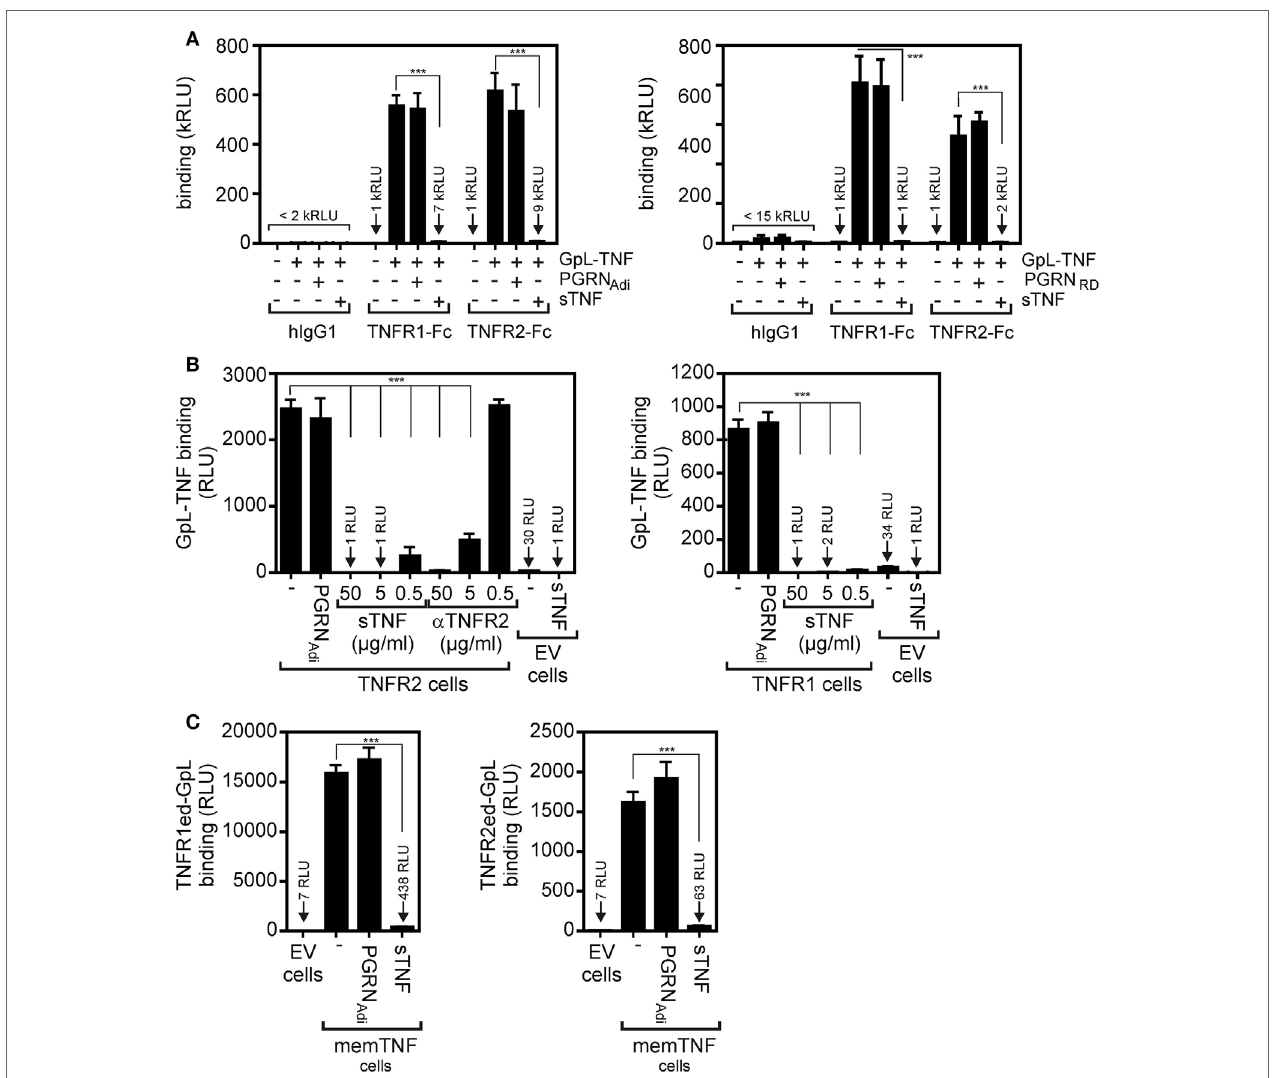
FigUre 1 | Preincubation with purified progranulin (PGRN) samples does not interfere with tumor necrosis factor (TNF)-tumor necrosis factor receptor-1 (TNFR1) and TNF–TNFR2 interaction in cell-free and cellular binding studies. (a) TNFR1-Fc and TNFR2-Fc or an irrelevant human IgG1 (Rituximab) were immobilized to black enzyme-linked immunosorbent assay (ELISA) plates. Where indicated wells were preincubated with 25 µg/ml untagged PGRN from Adipogen (PGRN Adi ) or 25 µg/ml myc-6xHis-tagged PGRN from R&D Systems (PGRN RD ) for 1 h. GpL-TNF was then added to reach a concentration of 10 ng/ml and finally bound GpL-TNF was quantified by measuring its GpL activity. As positive control for successful competitive binding inhibition groups were included, where 10 µg/ml of soluble TNF (sTNF) have been added instead of PGRN. (B) Human embryonal kidney cells 293 (HEK293) cells were transfected with empty vector (EV) or expression plasmids encoding a deletion mutant of TNFR1, where the death domain has been replaced by yellow fluorescence protein (YFP) (TNFR1) or deletion mutant of TNFR2, where the TRAF2 binding site has been replaced again by YFP (TNFR2). Next day, aliquots of cells (1 × 10 6 ) were preincubated with 500, 5,000, or 50,000 ng/ml of sTNF or 50,000 ng/ml PGRN Adi for 2 h at 37°C or remained untreated. Binding studies were performed in technical triplicates with 20 ng/ml GpL-TNF. In the experiment with TNFR2-transfected cells, a group was pretreated with 20 µg/ml of a blocking TNFR2-specific antibody ( α TNFR2). Please note, GpL-TNF binding of EV-transfected cells in the presence and absence of an excess of sTNF defines the low endogenous expression of TNF receptors which was about 1–3% of the ectopically expressed receptors. (c) EV-transfected control cells and membrane TNF (memTNF) expressing transfectants were incubated with 100 ng/ml of TNFR1ed-GpL or TNFR2ed-GpL and mixtures of these GpL variants with 2,000 ng/ml sTNF or 2,000 ng/ml PGRN Adi . After 90 min, unbound molecules were removed and specific binding was again obtained by subtracting non-specific binding (EV transfectants) from total binding (memTNF transfectants). Please be aware, the fact that specific binding of TNFR1ed-GpL is app. Tenfold higher than those of TNFR2ed-GpL reflects the fact that soluble monomeric TNFR1 has much higher affinity for TNF than soluble TNFR2 molecules and that non-saturating soluble receptor concentrations have been used in this competition assays. *** p <